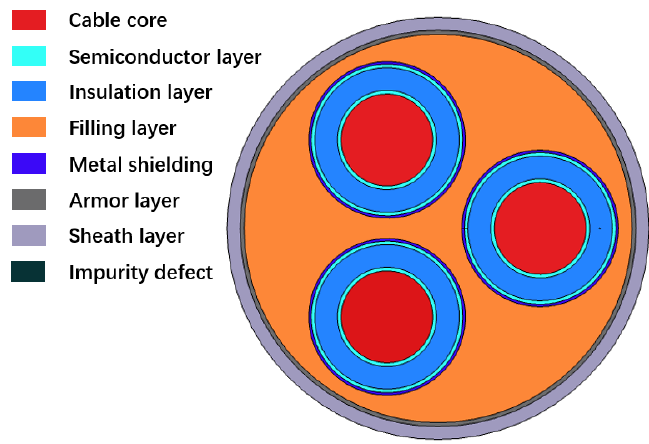
Figure 1. Finite element calculation modeling of three-phase cable containing impurities. Table 1. Geometric parameters of cable structure. Structure